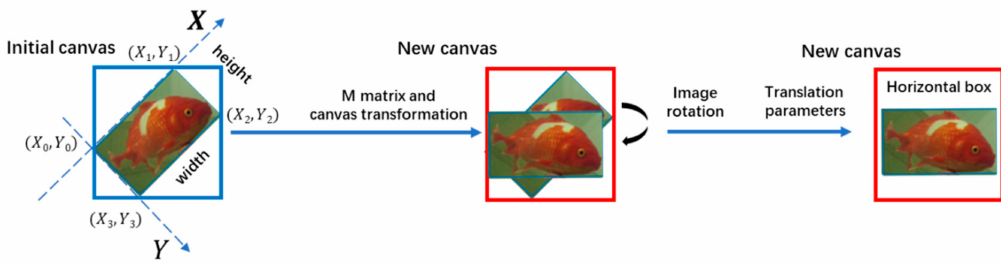
Figure 12. Rotation transformation flow chart. We construct a coordinate system whose direction is the same as that of a general image coordinate system. The upper left corner of the rotating frame is the origin, the positive x-direction is along the edge, and the positive y direction is along the edge down. The canvas includes all target features in the rotating frame. Left: Initial rotation box, labeling all related symbols. Right: Only the transformation process is included.